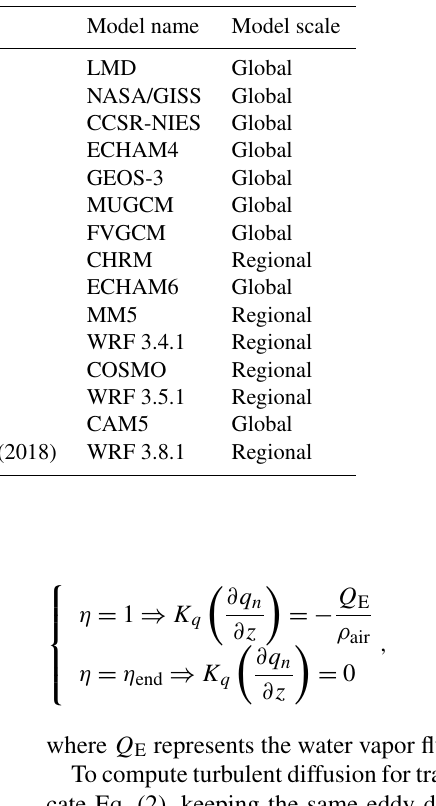
Table 1. The different WVT implementations (including the present): reference, name of the models in which the WVT tool has been implemented and scale of these